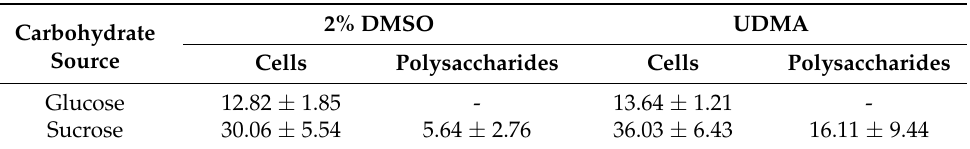
Figure 4. Confocal laser scanning microscopy analyses of the biofilms of S. mutans UA159 formed in the presence and absence of UDMA for 24 h (scale bar: 5 µ m). To visualize the biofilms, the cells were stained using SYTO13 (green, a – d ) and the polysaccharides were stained using Alexa 647 (red, c and d ). To assess the viable cells, the biofilms were assayed using a LIVE-or-DIE TM viability/cytotoxicity kit ( e – h ); in this method, compromised whole cells are stained green and the dead cells are stained red. DMSO was used as a vehicle for UDMA, and the cells grown in the absence of UDMA (2% DMSO) were used as the control. The quantitative fluorescence data are presented in Tables 1 and 2. Table 2. Biovolume ( µ m 3 / µ m 2 ) of the biofilms of S. mutans UA159 formed in the presence and absence of UDMA on saliva-coated surfaces. After 24 h biofilm development, the biofilms were stained with SYTO13 (cells) and Alexa 647 (polysaccharides). DMSO was used as a vehicle for UDMA, and cells grown without UDMA (2% DMSO) were used as the control. The biovolume was calculated based on five randomly selected areas of each